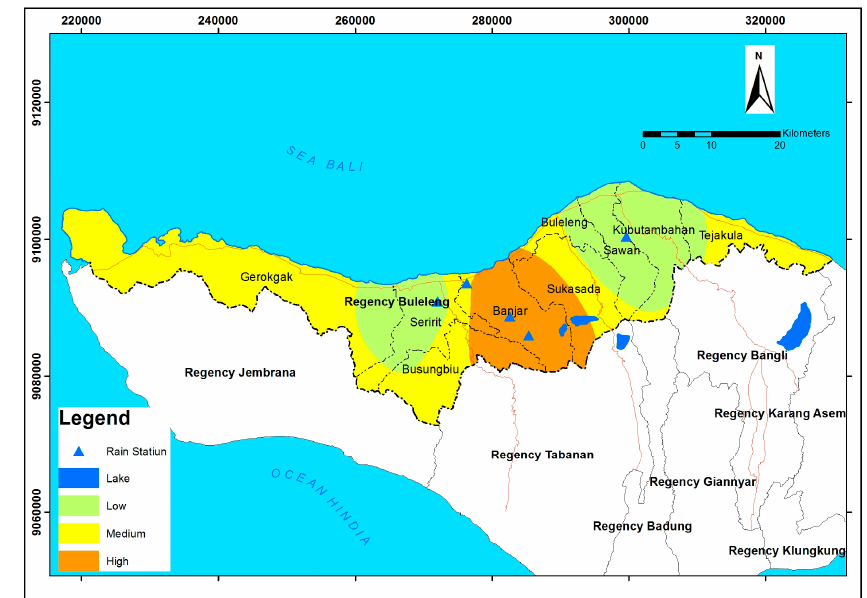
Figure 8. Rainfall intensity on the study area.